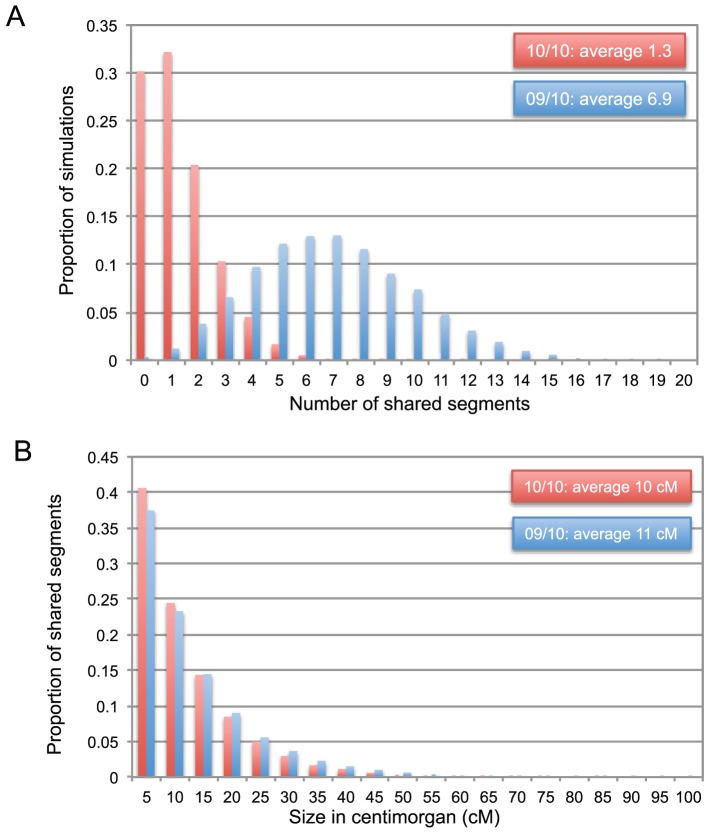
Expected frequency distribution of number and size (in cM) of genomic segments shared IBD by the obligate carrier and affected individuals.(A) Distribution of the expected number of shared segments. (B) Distribution of the expected size of shared segments. (Red) Expected sharing between the obligate carrier and the nine affected individuals. (Blue) Expected sharing between the obligate carrier and eight of the nine affected individuals (blue). Frequency distributions were obtained from 10,000 simulated segregations of 22 autosomes with genetic size according to Kong et al. [15].